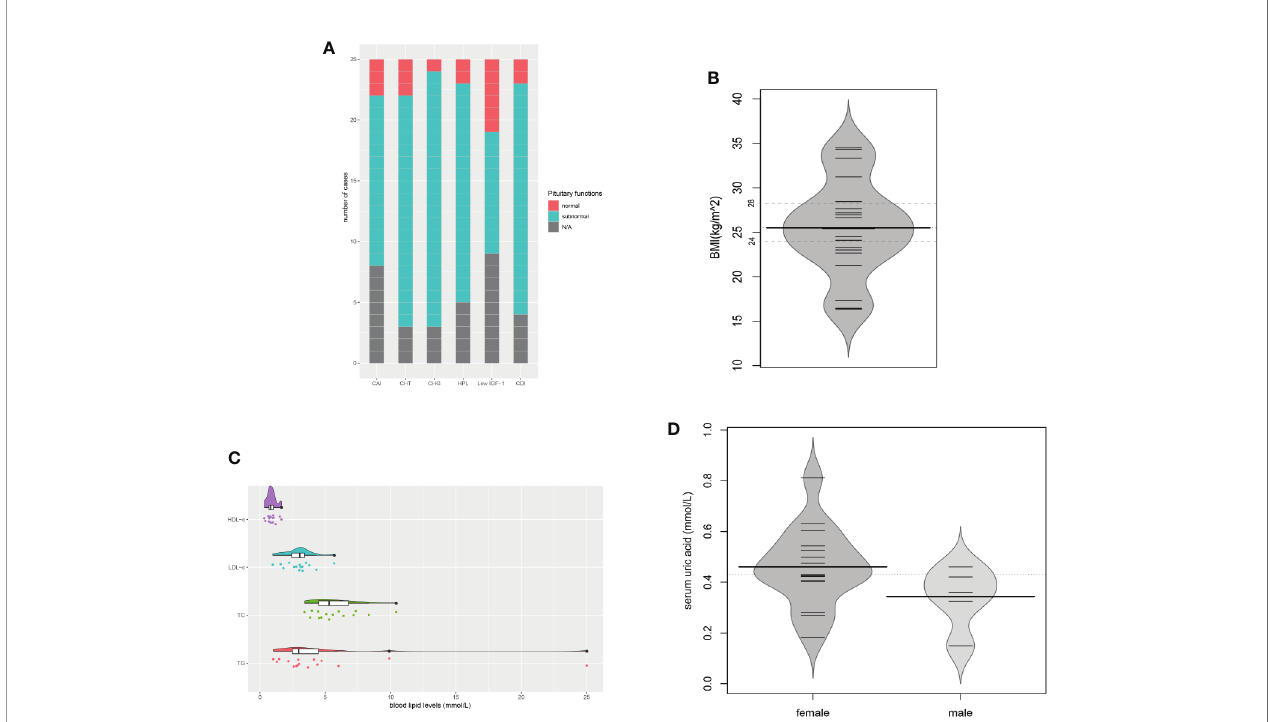
FIGURE 6 | Pituitary dysfunctions and metabolic disorders. (A) Description of hypopituitarism of all the cases; (B) BMIs of the evaluated cases (n = 20); (C) Blood lipid levels of the evaluated cases (n = 16); (D) Serum uric acid levels of the evaluated cases (n = 20). CAI, central adrenal insuf fi ciency; CHT, central hypothyroidism; CHG, central hypogonadism; HPL, hyperprolactinemia; CDI, central diabetes insipidus; N/A, not